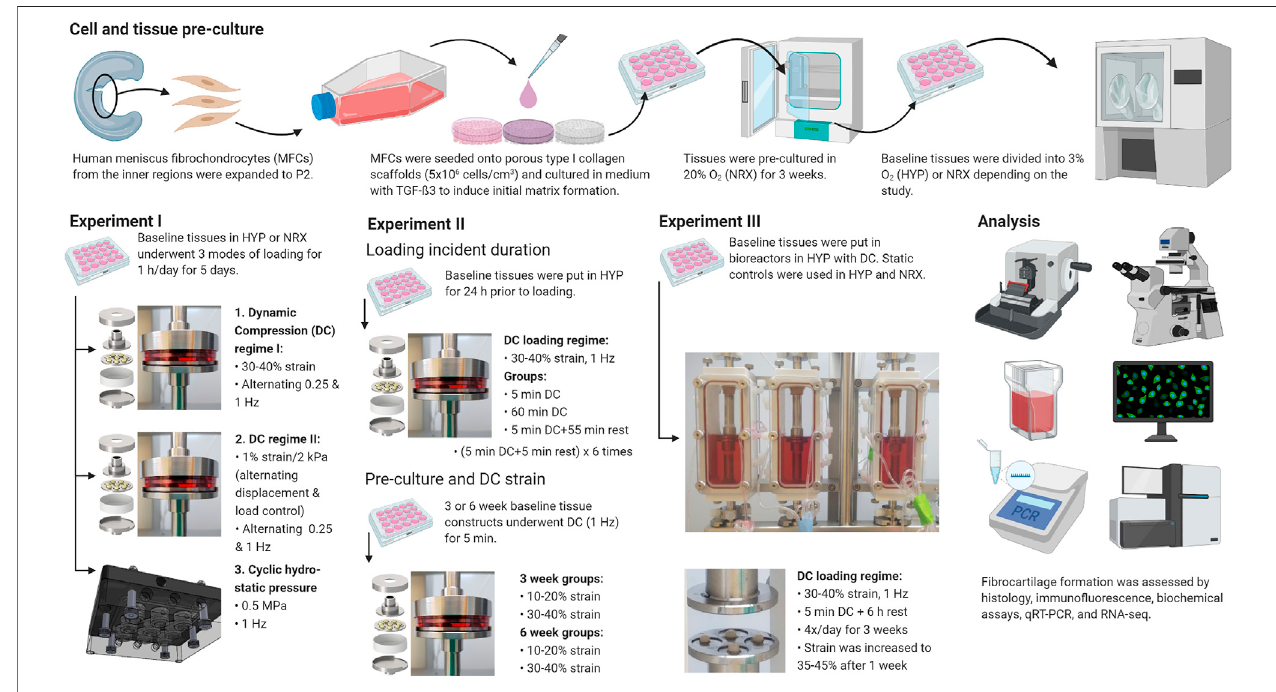
FIGURE 1 | Experiment outlines. Created with Biorender.com